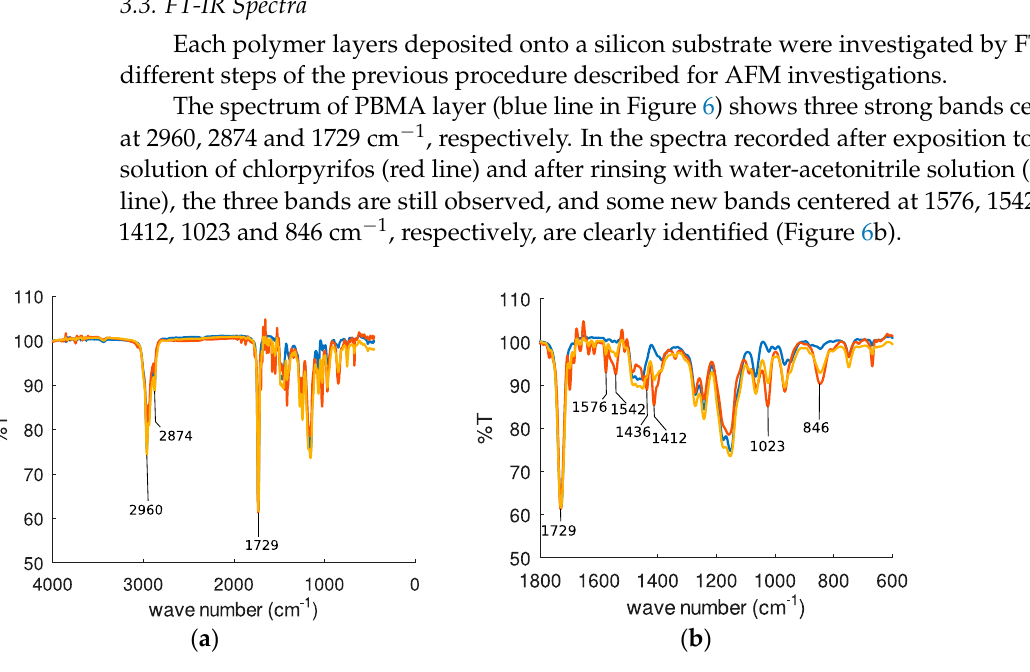
Figure 6. FT-IR spectra of a PBMA layer (thickness: 200 nm) deposited on a silicon substrate. In blue, spectrum of PBMA layer after deposition onto silicon substrate; in red, this layer immerged overnight in a water-acetonitrile solution containing 40 mg/L of chlorpyrifos; and in yellow, this layer washed with water-acetonitrile solution during 1.5 h ( a ) full extended spectrum; ( b ) zoom corresponding to 400–1800 cm − 1 range of spectrum shown in a).